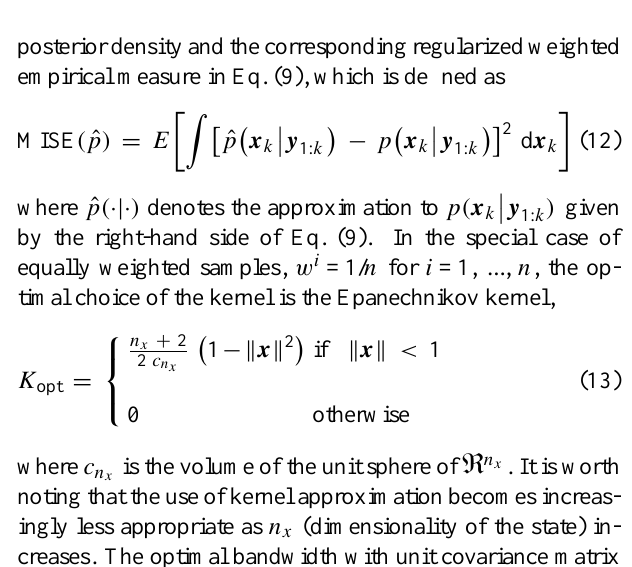
Fig. 4. The flow diagram of regularized particle filter with MCMC move step in the lagged filtering approach.